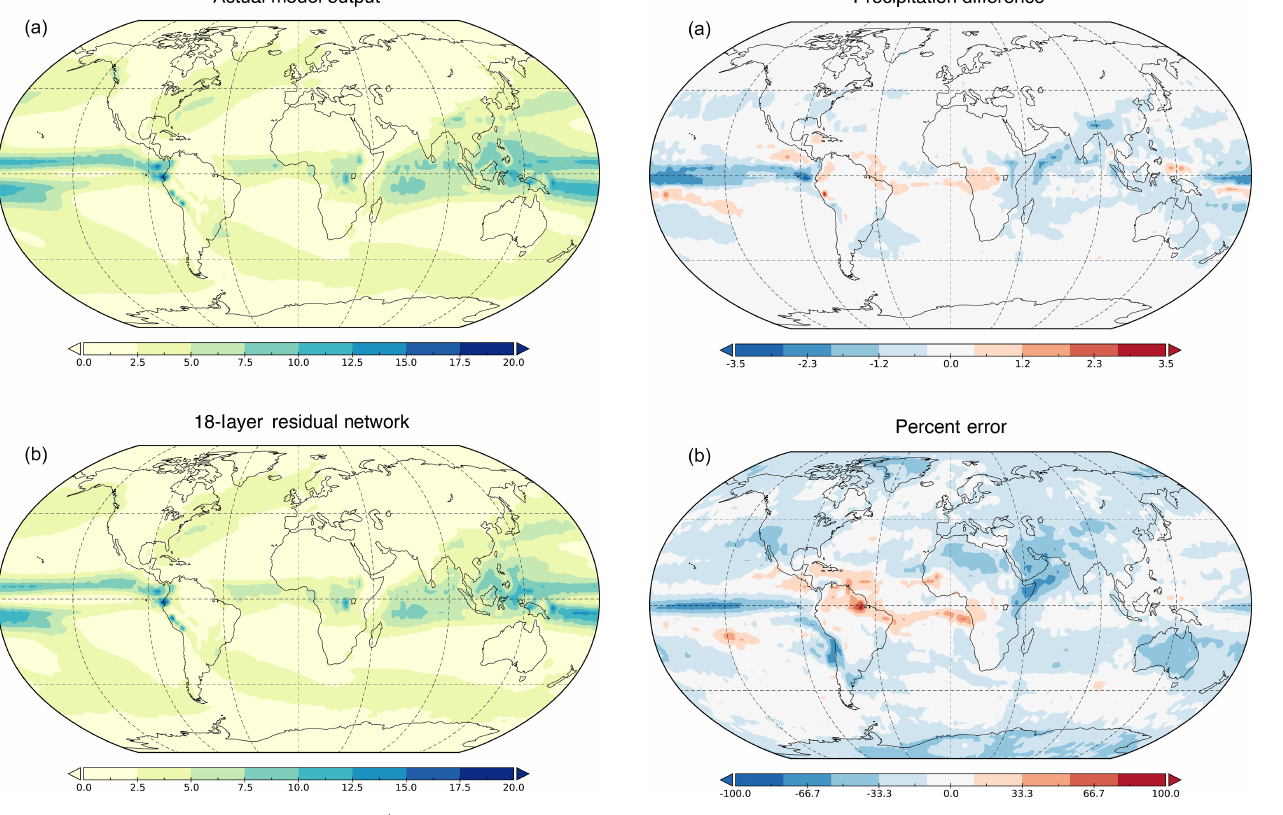
Figure 3. Comparison of the average precipitation outputs (mm d − 1 ) of the CanESM2 ( B ) and the 18-layer residual network ( ˆ B ) using a window size of 60 over the years 1969–1989. Top shows ˆ B − B . Bottom shows the percent error between ˆ B and B . The residual network tends to underpredict near the Equator, midlati- tude storm tracks, and areas associated with monsoon